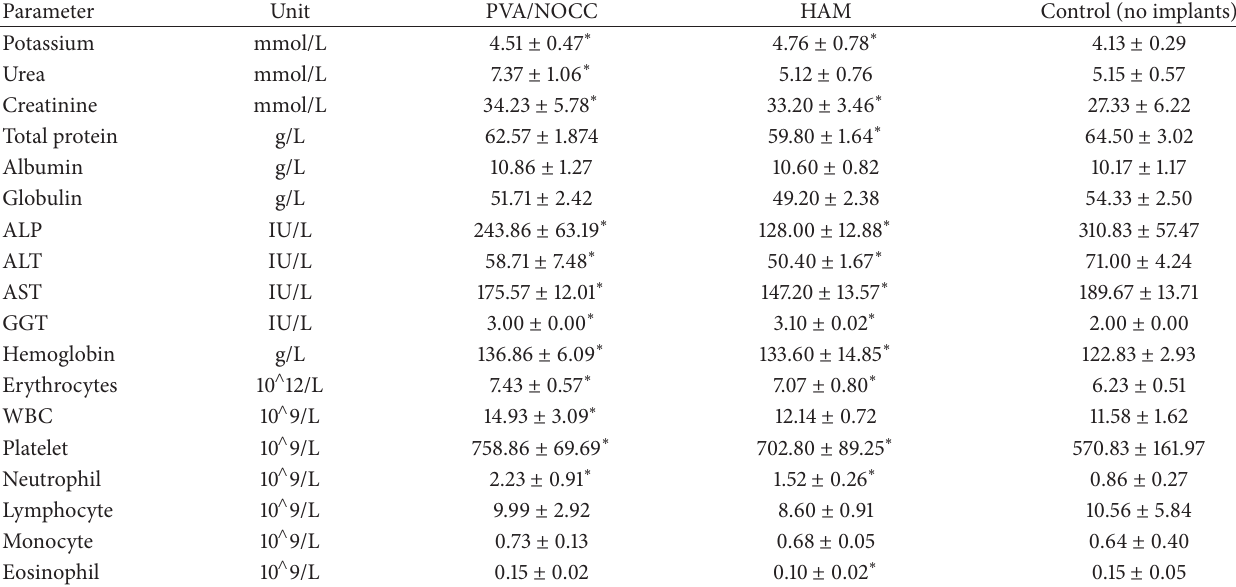
Table 3: Differences in the level of some biochemical indicators among groups of animals implanted with PVA/NOCC and HAM and control on the 15th day of implantation (mean ±